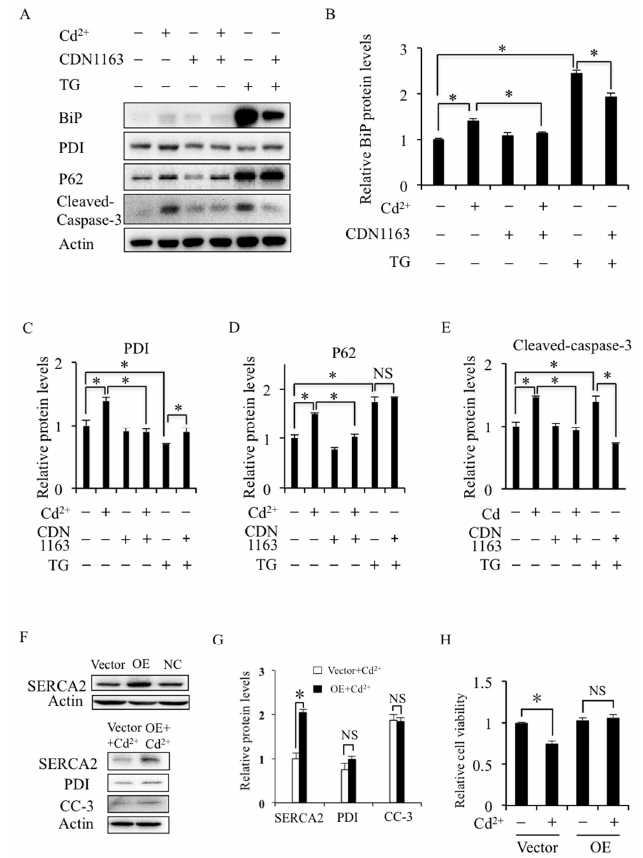
Figure 3. Effects of SERCA modulators on ER stress, autophagy, and apoptosis. ( A ) Effect of Cd 2+ , CDN1163, and TG on the expression of ER stress biomarkers BiP and PDI, autophagy biomarker p62, and apoptosis biomarker cleaved caspase-3 (CC-3) were detected by Western blotting. ( B – E ) Quantification of the relative protein levels was performed using the software Image J 1.54c. ( F , G )